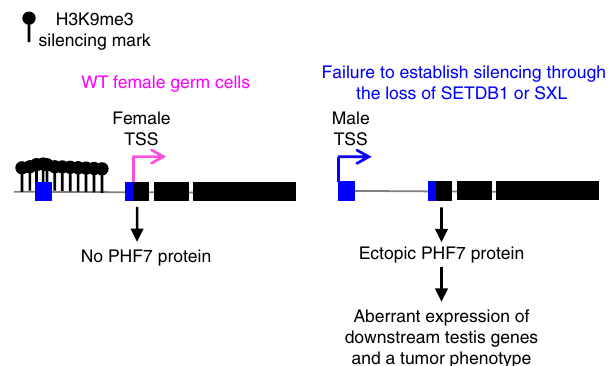
Fig. 7 Schematic summary of discrete facultative heterochromatin island assembly at phf7 . In female germ cells, SETDB1, together with SXL, directs assembly of a highly localized H3K9me3 domain around the testis-speci fi c TSS. In germ cells lacking SETDB1 or SXL protein, the dissolution of the H3K9me3 domain correlates with ectopic testis-speci fi c phf7-RC transcription and PHF7 protein expression. Ectopic PHF7 protein activity leads to activation of downstream testis genes and a tumor (Fig. 6h), including phf7 (Fig. 4b) and CG34434 (Fig. 4c). Based